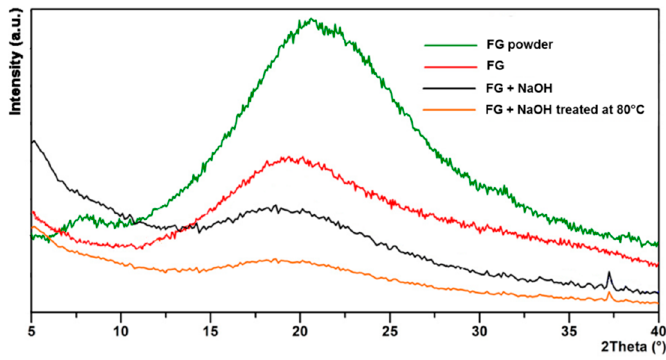
Figure 3. WAXDpatternsofFGpowder, FG,FG + NaOH,andthermaltreatedFG + Figure 3. WAXD patterns of FG powder, FG, FG+NaOH, and thermal treated FG+NaOH electrospun mats.